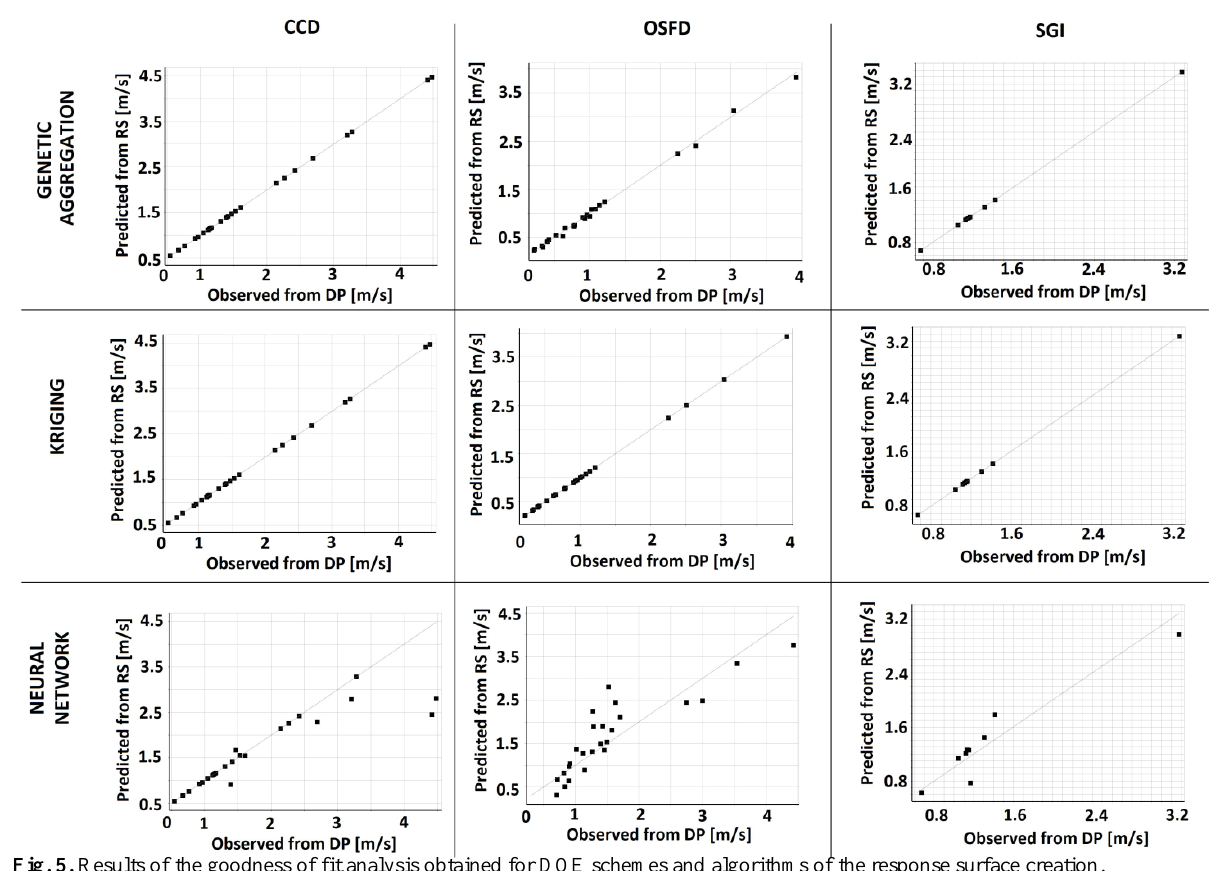
Fig. 5. Results of the goodness of fit analysis obtained for DOE schemes and algorithms of the response surface